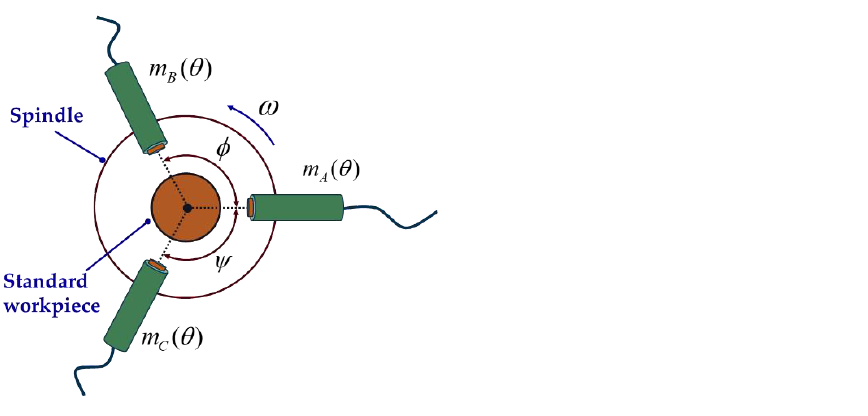
Figure 4. Schematic diagram of sensor distribution of three-point method.